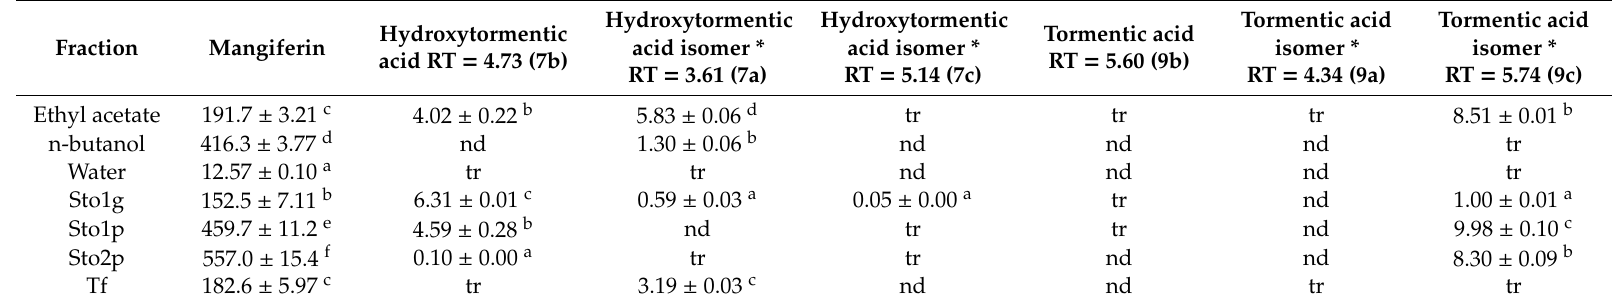
Table 5. Quantification of selected secondary metabolites present in the fractions of A. theiformis mg / g